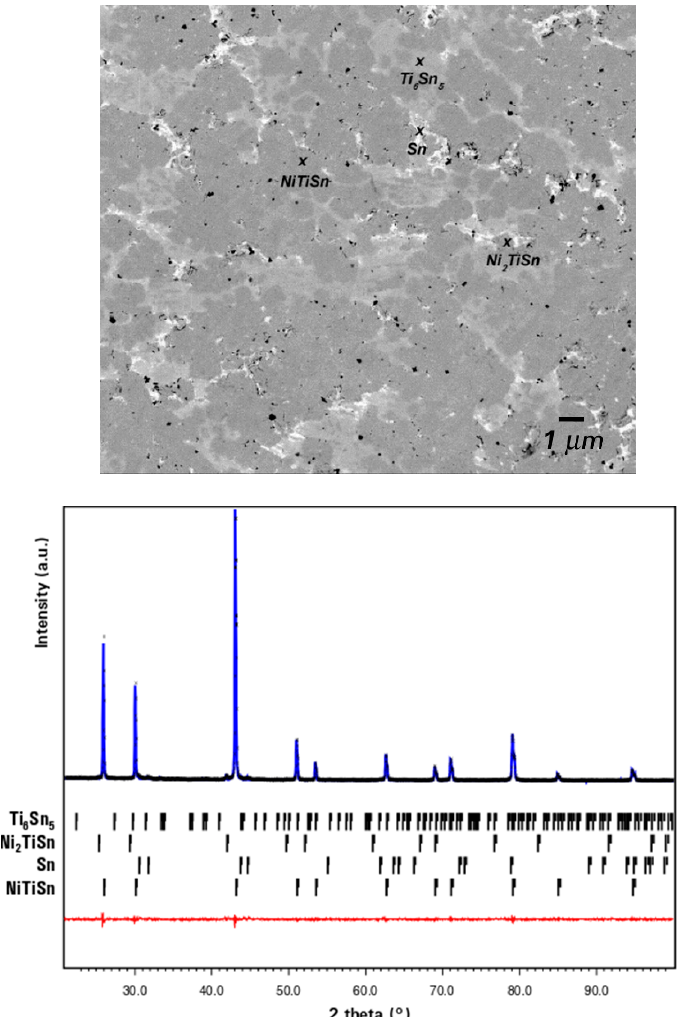
Figure 1. SEM micrograph of an arc-melted sample and profile fitting of its XRD pattern (CuK α , 4-components Ti 6 Sn 5 , Ni 2 TiSn, Sn, and NiTiSn, from top to bottom, Rp = 3.4, wRp = 4.7, GoF = 1.9) after 10 days of annealing at 750 °C.